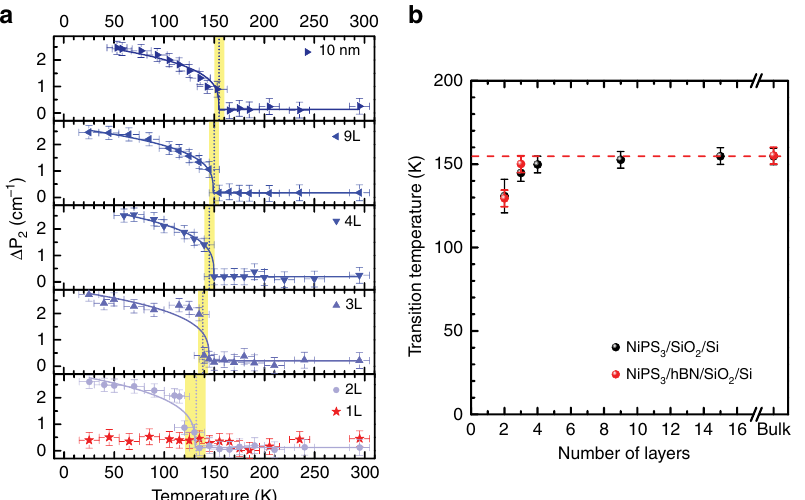
Fig. 5 Thickness dependence of Néel temperature for few-layer NiPS 3 . a Temperature dependence of magnetic-order-induced frequency difference Δ P 2 for various thicknesses. The error bars indicate experimental uncertainties, the dashed vertical lines indicate the Néel temperature for each thickness, and the solid curves are fi tting results by using the spin-induced phonon frequency shift model. b Estimated antiferromagnetic transition temperature for various thicknesses by using Δ P 2 of NiPS 3 samples on SiO 2 /Si (black) and hBN/SiO 2 /Si (red) substrates. The error bars indicate experimental uncertainties, and the red dashed line shows bulk Néel temperature (155